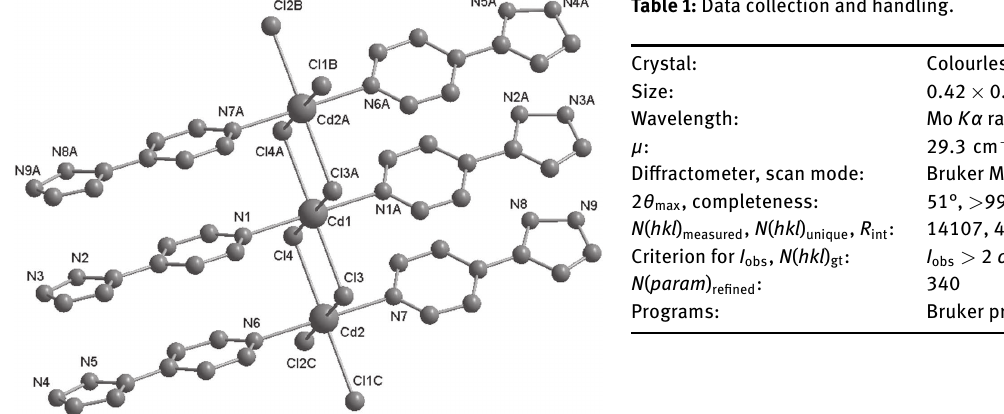
Table 1: Data collection and